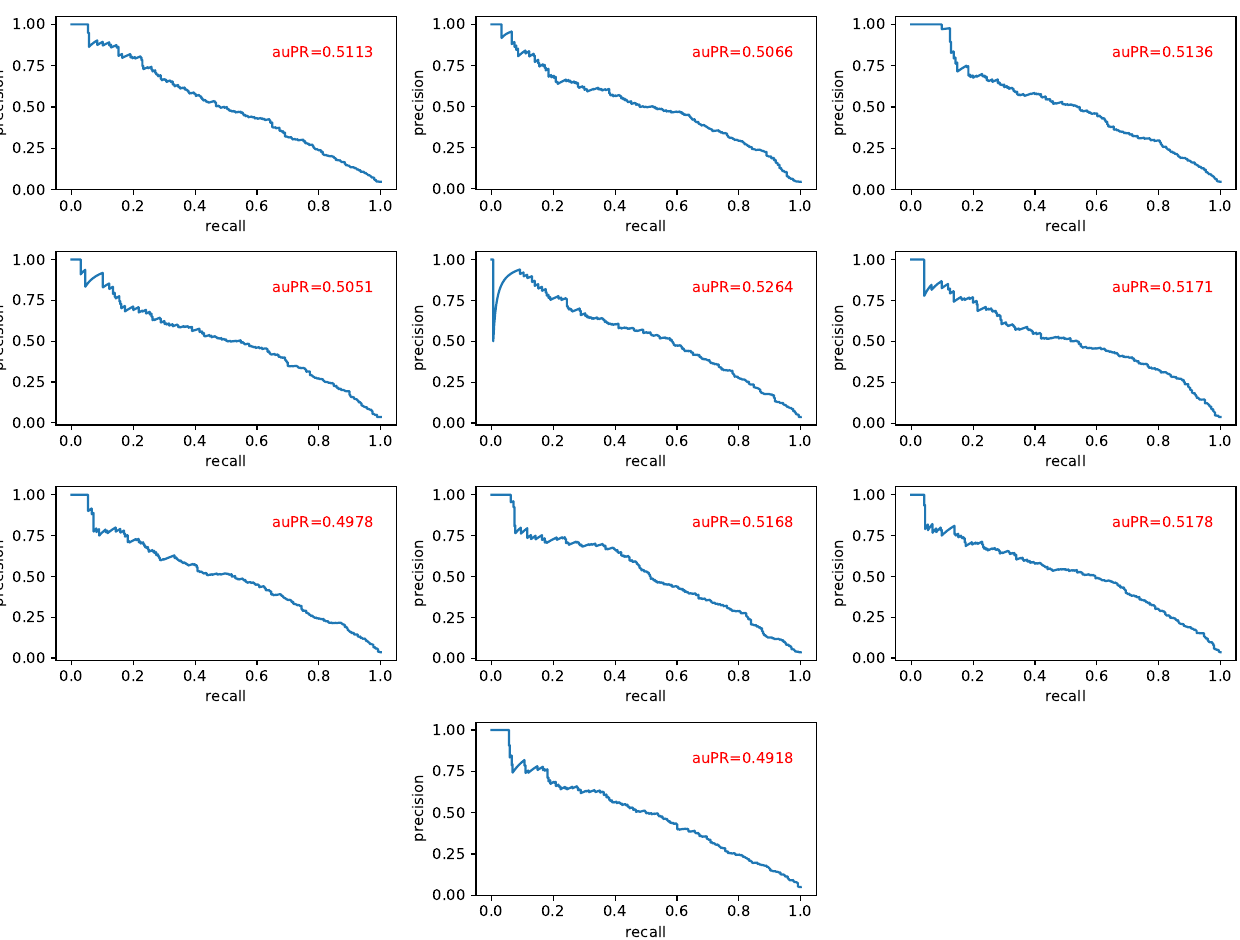
Figure 9. The test results obtained by using the SN-GGAT method to execute the link signed prediction task on the Human dataset, where each sub-graph represents one prediction